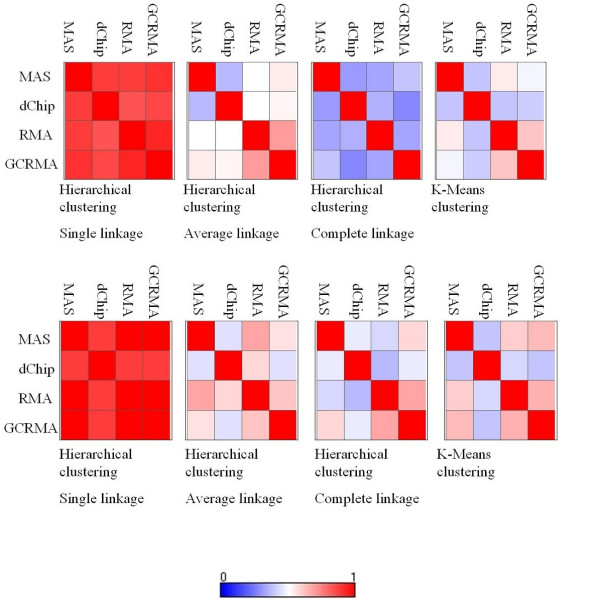
Jaccard indices of clustering results. Results were obtained using correlation distance on a fixed number of probe sets, after different pre-processing procedures and by different clustering algorithms. A. AML dataset, k = 12 clusters, 3000 probe sets. B. CNS dataset, k = 5 clusters, 1000 probe sets.